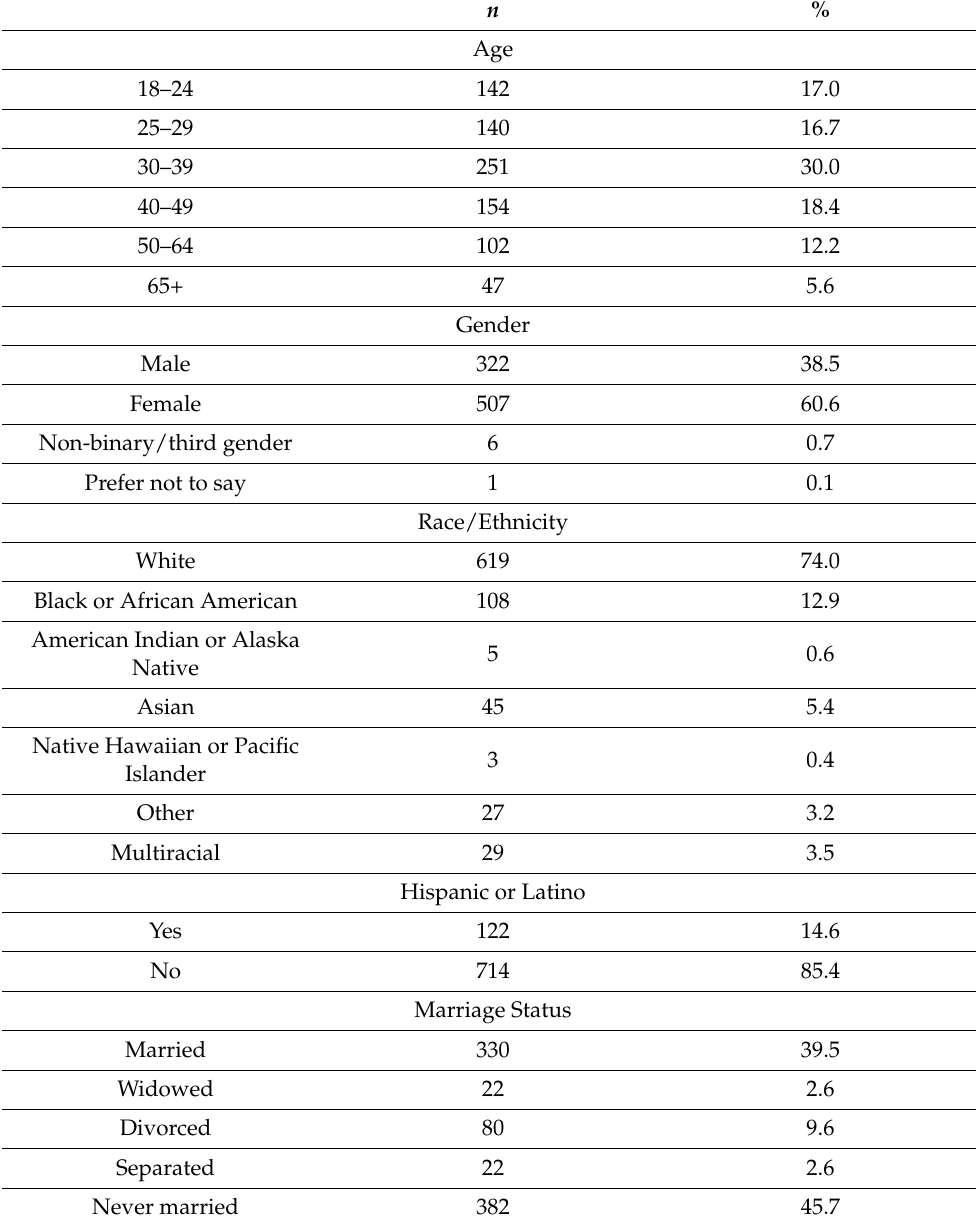
Table 1. Sample demographic